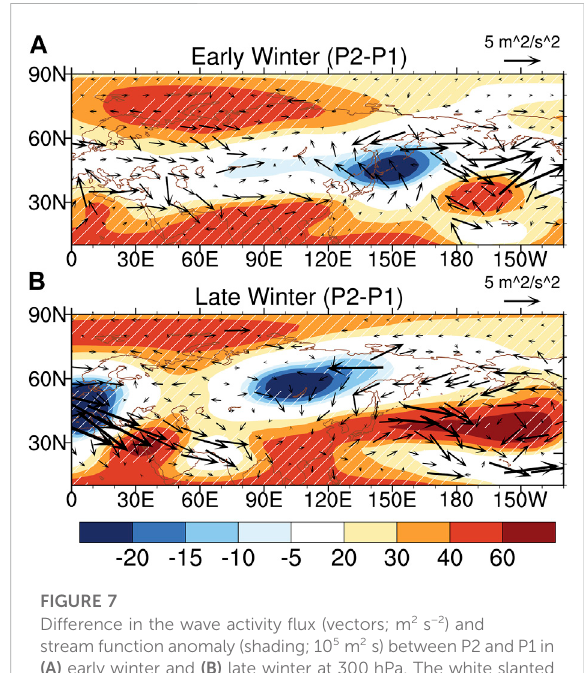
FIGURE 7 Difference in the wave activity fl ux (vectors; m 2 s − 2 ) and stream function anomaly (shading; 10 5 m 2 s) between P2 and P1 in (A) early winter and (B) late winter at 300 hPa. The white slanted lines represent p <